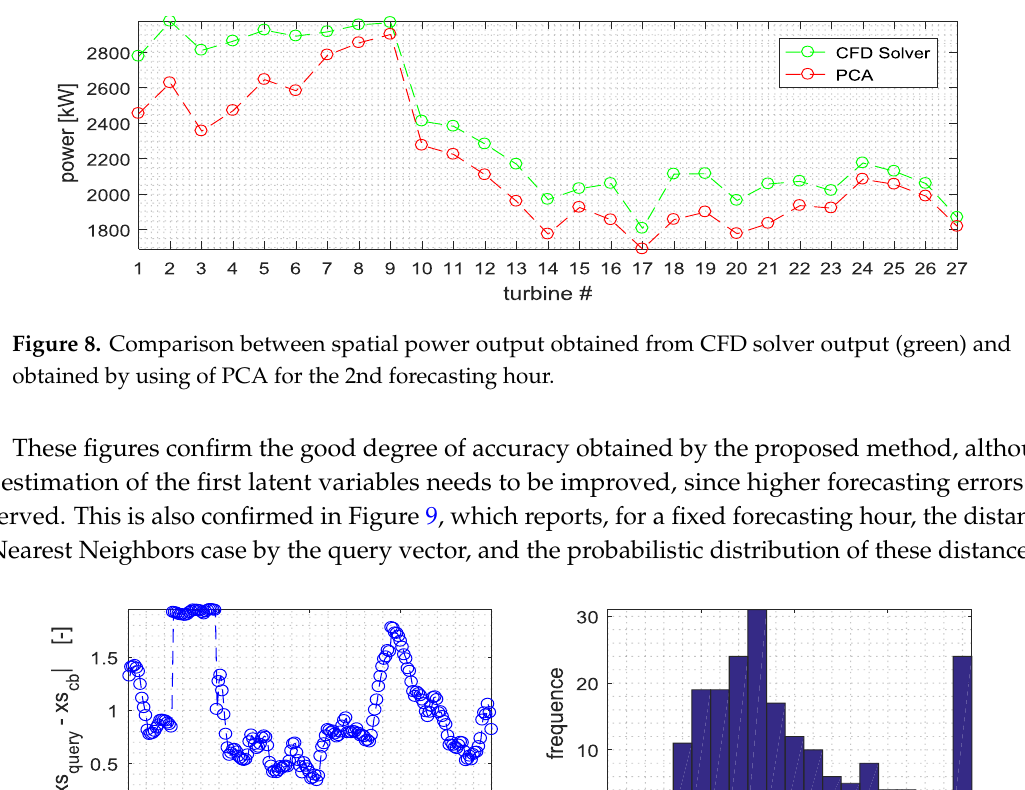
obtained by using of PCA for the 2nd forecasting hour.